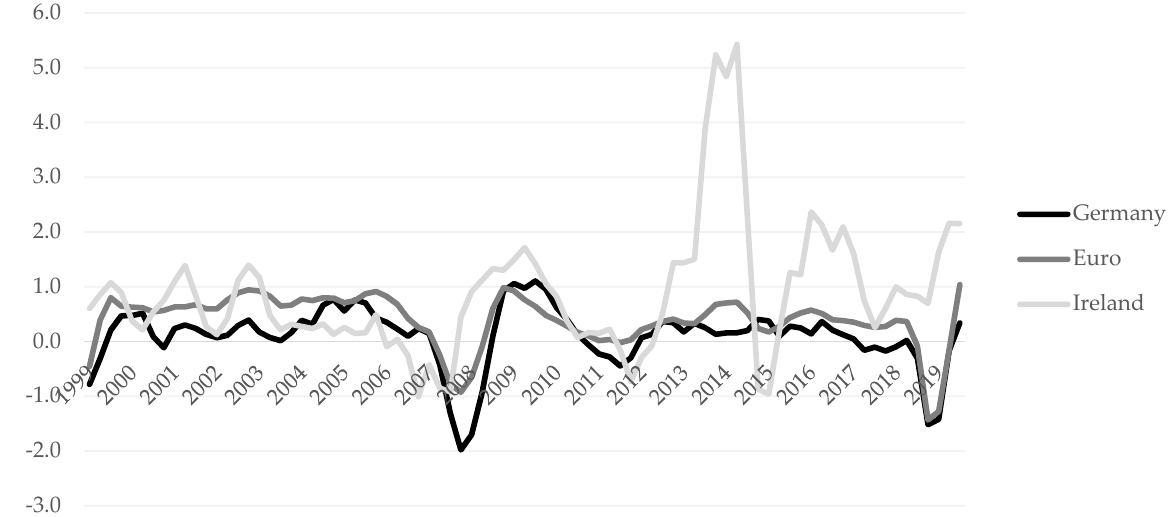
Figure 3. Labour productivity growth in euro area, Germany and Southern euro area members. Source: Own calculations, based on Macrobond. Note: Quarterly growth rates are reported as rolling moving averages over a one-year period. Southern Euro includes Greece, Italy, Portugal and Spain. Table 4. Unemployment rate growth—averages of country-level correlation coefficients for differ- ent country groups.